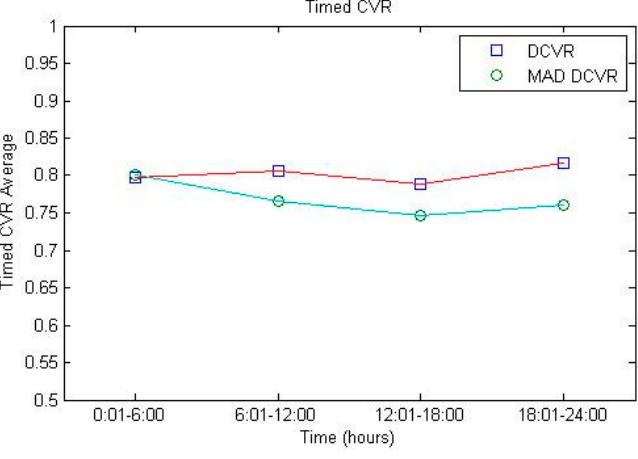
Figure 10. Average CVR factors of all D/Ls by time.